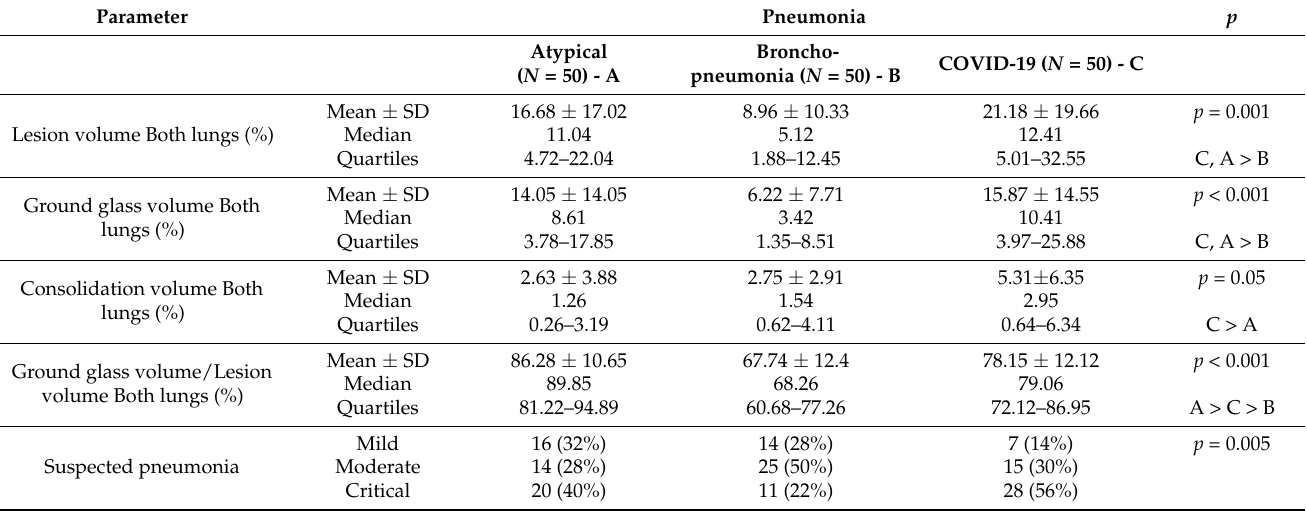
Table 1. The results of statistical analysis of parameters reported by the software after automatic assessment of HRCT images, in three subgroups of